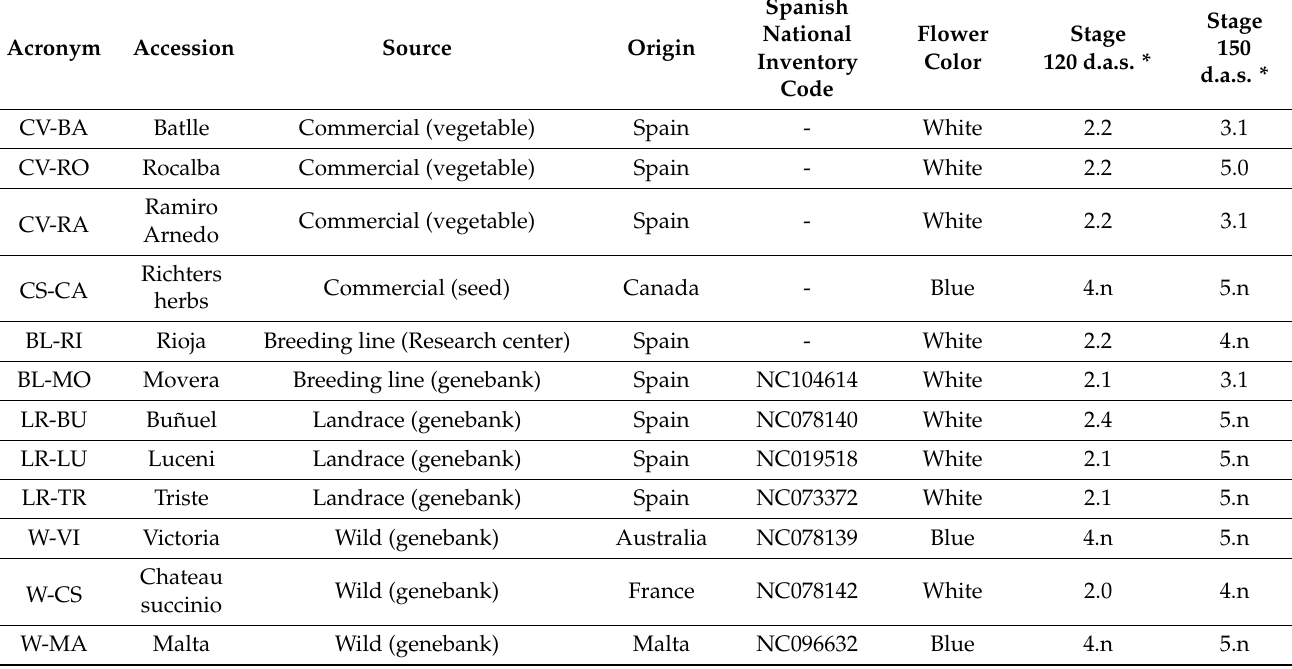
Table 1. Borage ( Borago officinalis L.) genotypes evaluated and plant stages during sampling: 120 and 150 days after sowing